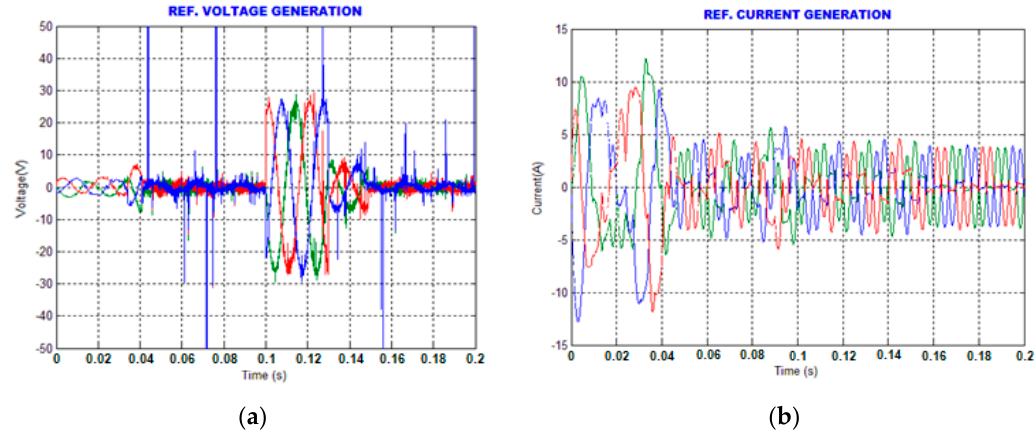
Figure 11. Waveform for ( a ) reference voltage ( b ) reference current.